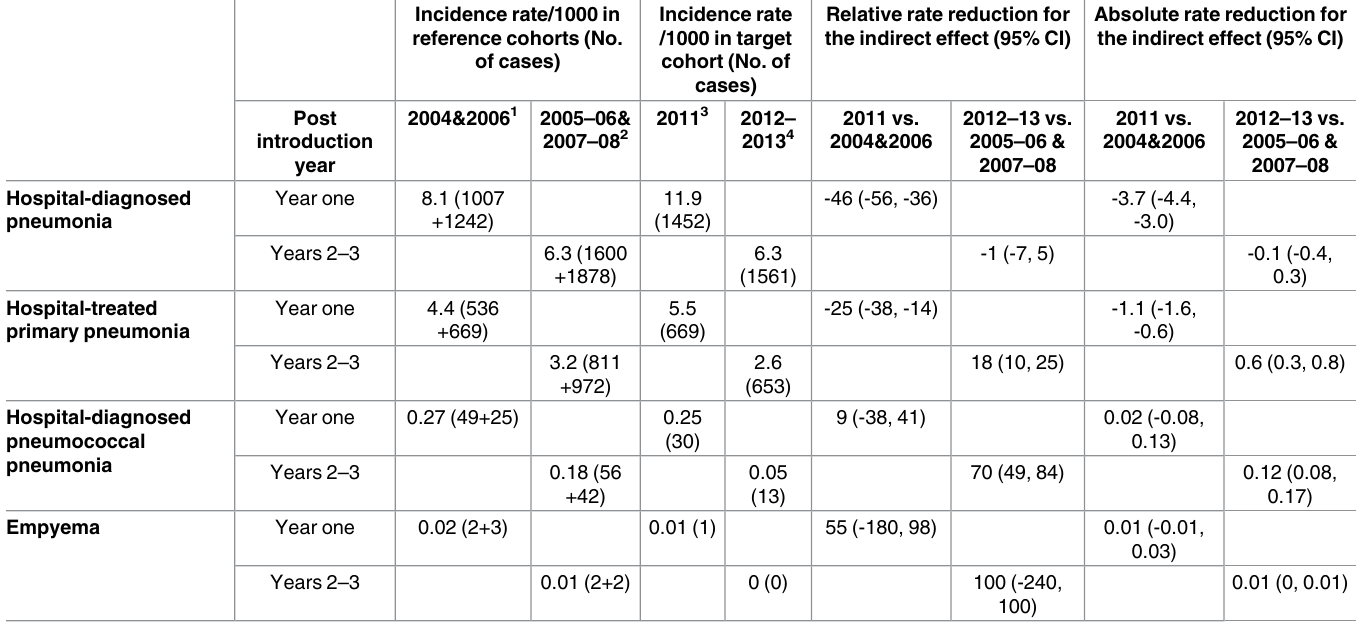
Table 3. Rates of pneumonia and the corresponding rate reductions in unvaccinated study cohort vs. referencecohorts.